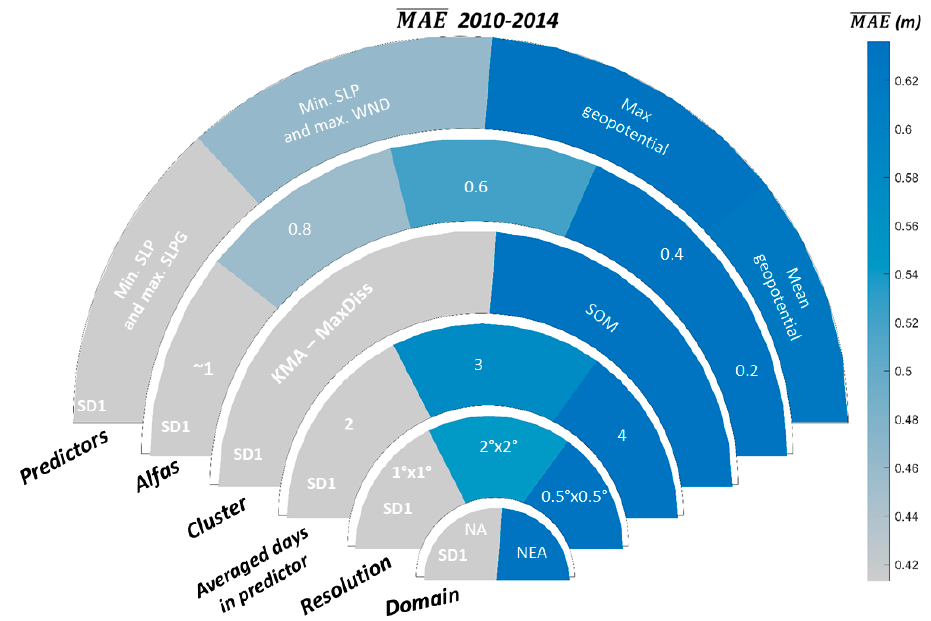
Figure 4. MAE of four validation years (2010 to 2014) for the optimal configuration (SD1) and the other different set-ups of the sensitivity tests described in Table 1.